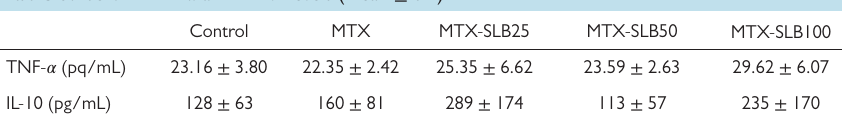
Table 3. Serum TNF- 𝛼 and IL-10 Levels (Mean ± SD)